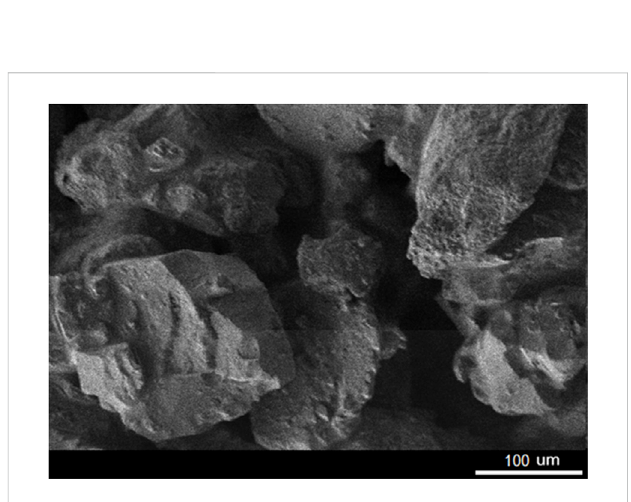
FIGURE 14 The SEM image of oil sands from Fengcheng oil fi